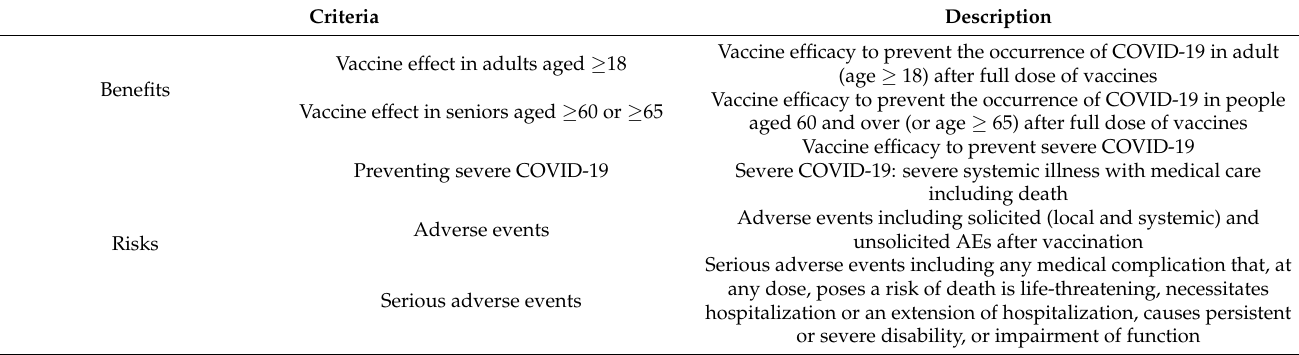
Table 1. Definitions of the benefit and risk criteria.